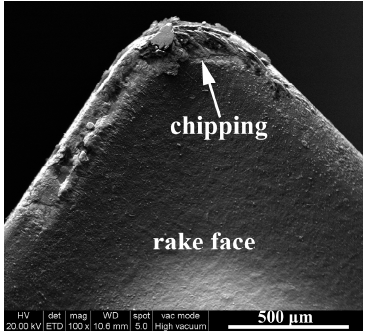
Figure 11. SEM image of rake face of the TiAlN-coated insert after machining for 6 min (cutting speed of 60 m/min, feed rate of 0.1 mm/r, depth of cut of 1.0 mm).